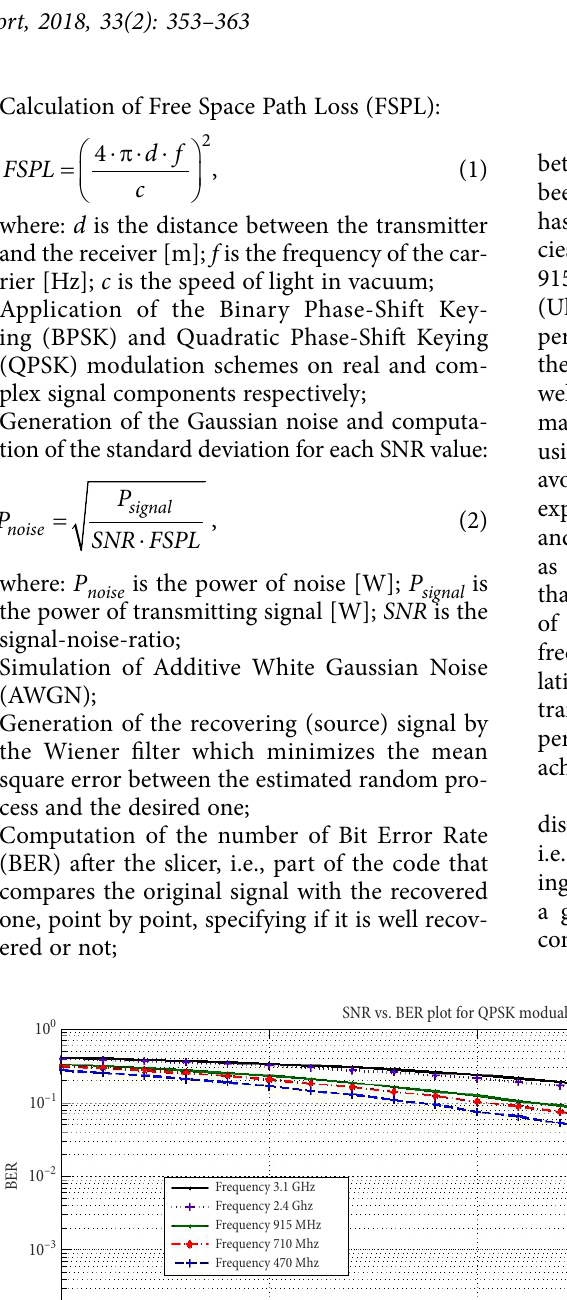
Frequency 3.1 GHz Frequency 2.4 Ghz